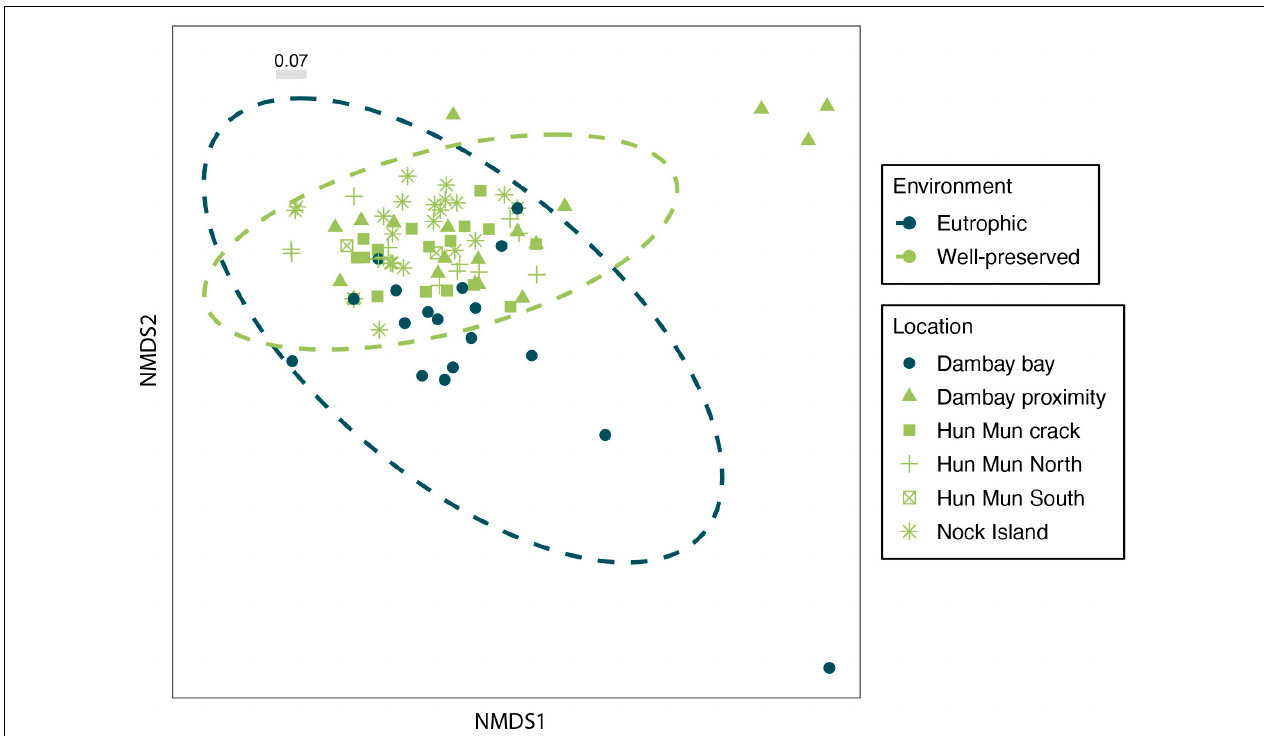
FIGURE 3 | Non-metric multidimensional scaling (nMDS) ordination of fish communities obtained from sponge nsDNA based on Bray-Curtis distances. Colors show differences between Eutrophic (blue) and Well-Preserved (green) environments. Each location is represented by a different shape. Gray bar represents the percentage of